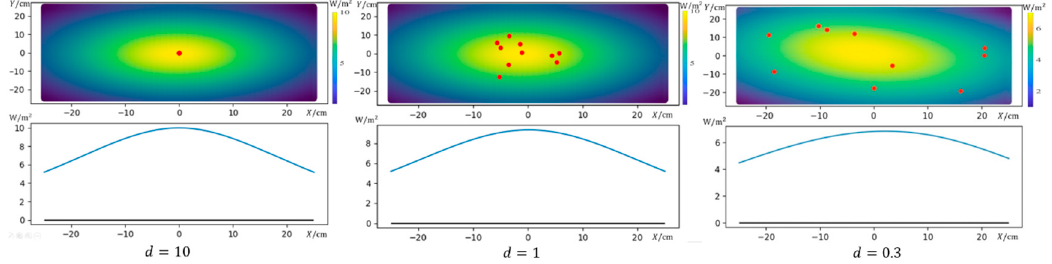
Figure 8. Blue LED simulation diagram. Table 2. Simulation results.